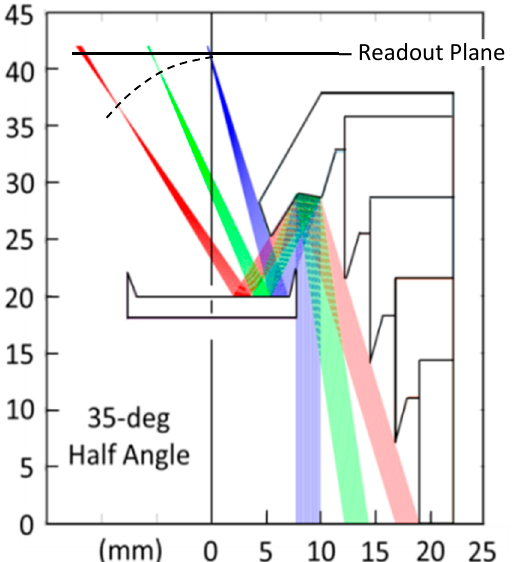
Figure 4. Cross-section of the wide-field-angle Ritchey-Chrétien telescope (RCT) which is the basis of the current investigation.